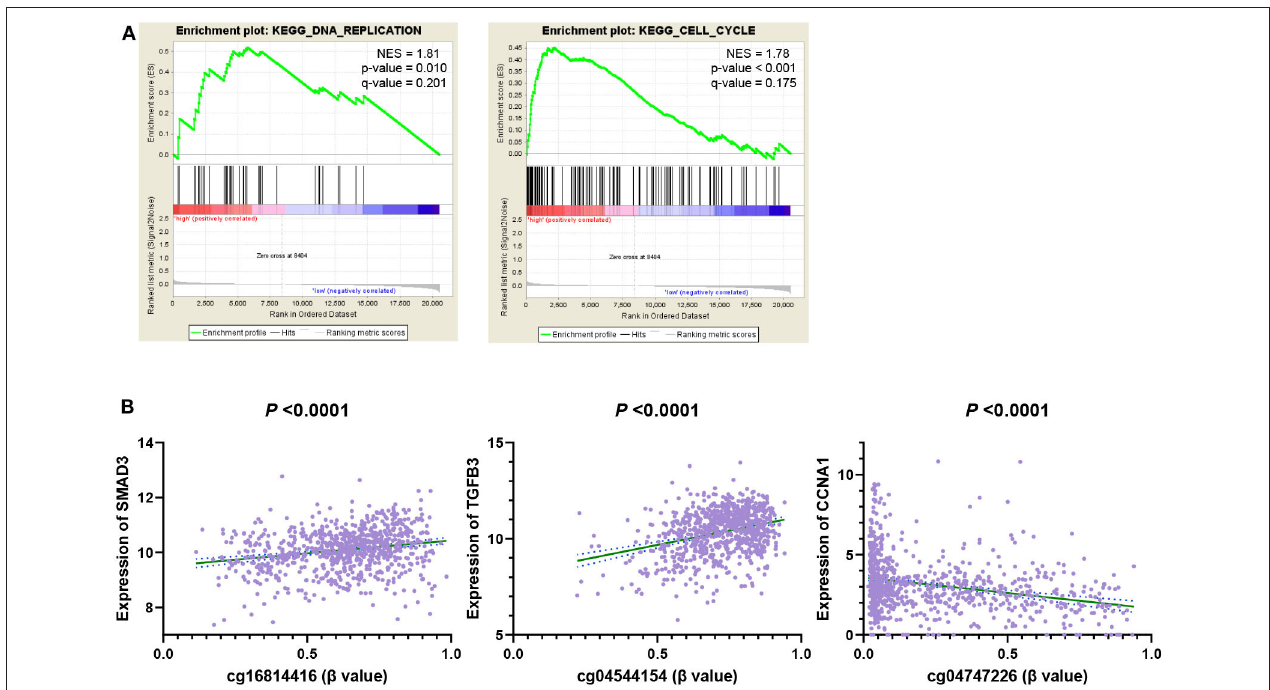
FIGURE 7 | GSEA analysis 6 DNA methylation site driven gene related pathway. (A) GSEA KEGG Pathways enrichment analysis genes of high-risk individuals. (B) The correlation between 6 CpG markers and genes in the enrichment